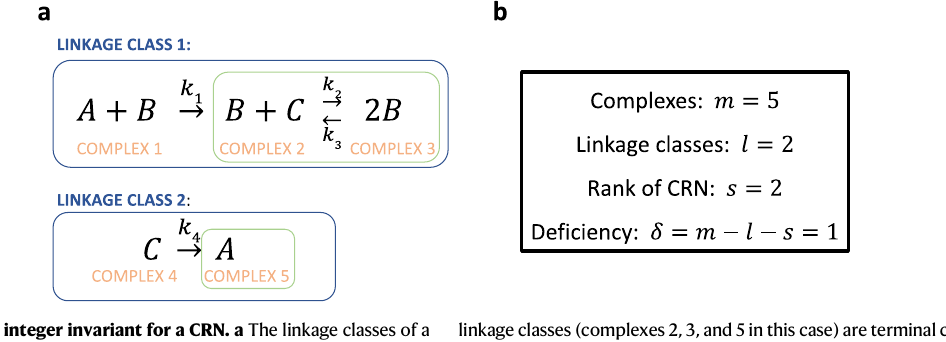
linkageclasses(complexes2,3,and5inthiscase)areterminalcomplexes;allother complexesarenon-terminalcomplexes.SeeSISectionS1.2foracompletetechnical overview. b De fi ciencyiscalculatedfromthenumberofcomplexes,linkageclasses and the rank of the CRN, as shown. The rank of the CRN is the number of linearly independent reactions, ie. the dimension of the stoichiometric subspace of the CRN (see SI Section